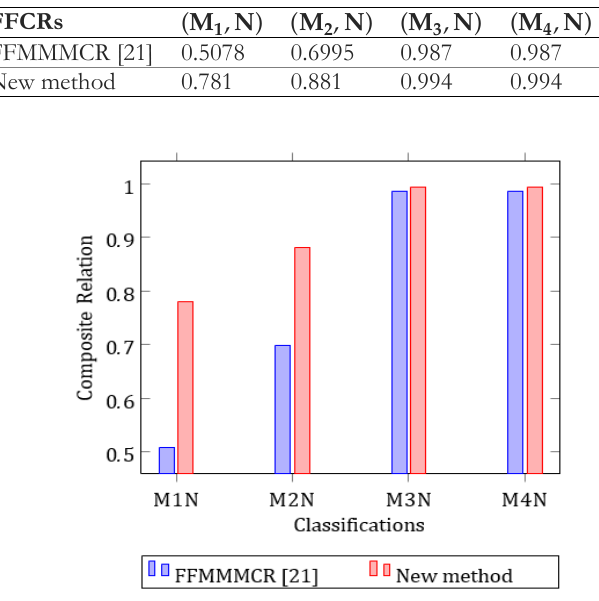
Fig. 2. Graphical representation of FFCRs for problem 1.